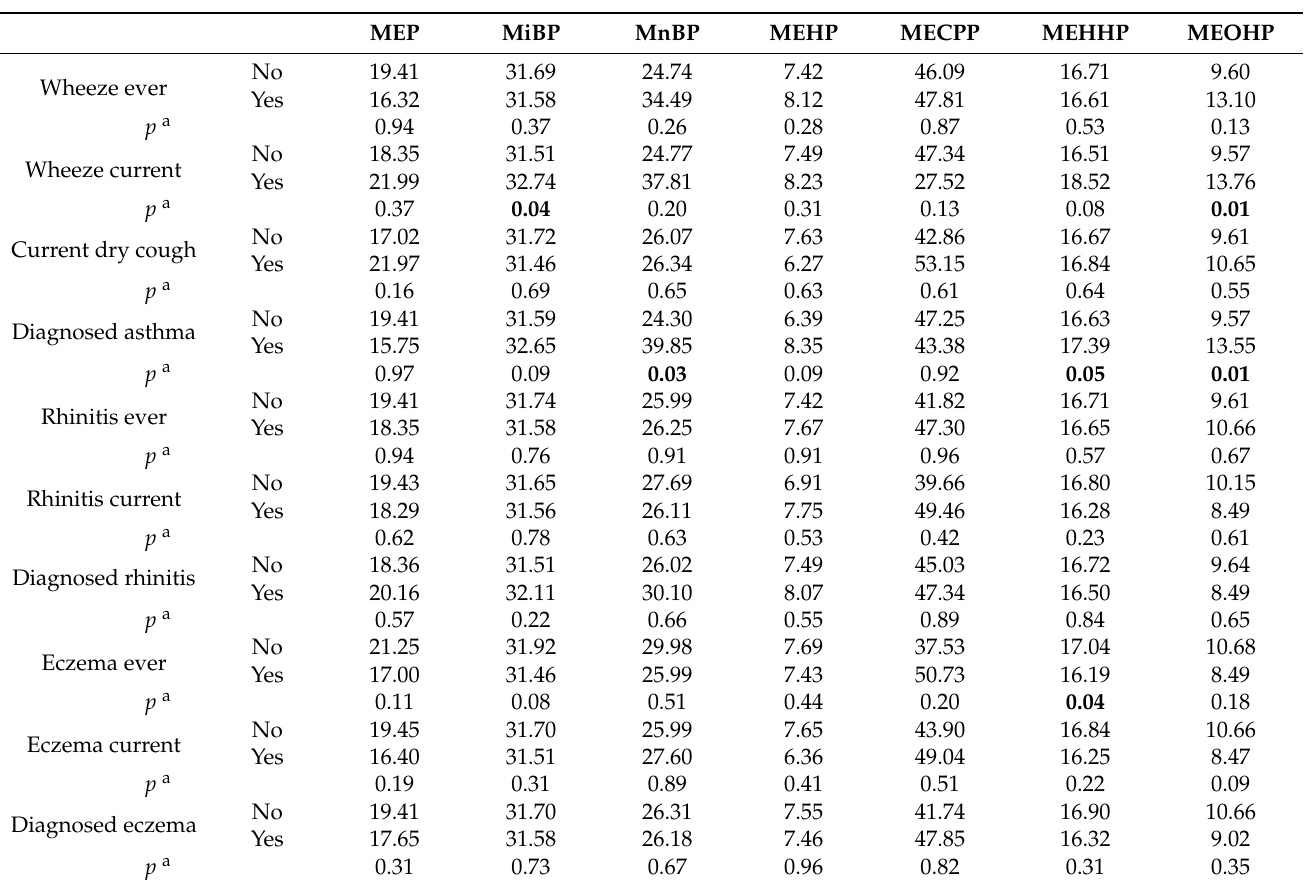
Table 3. Median concentrations ( µ g/L) of phthalate metabolites among children with and without allergic